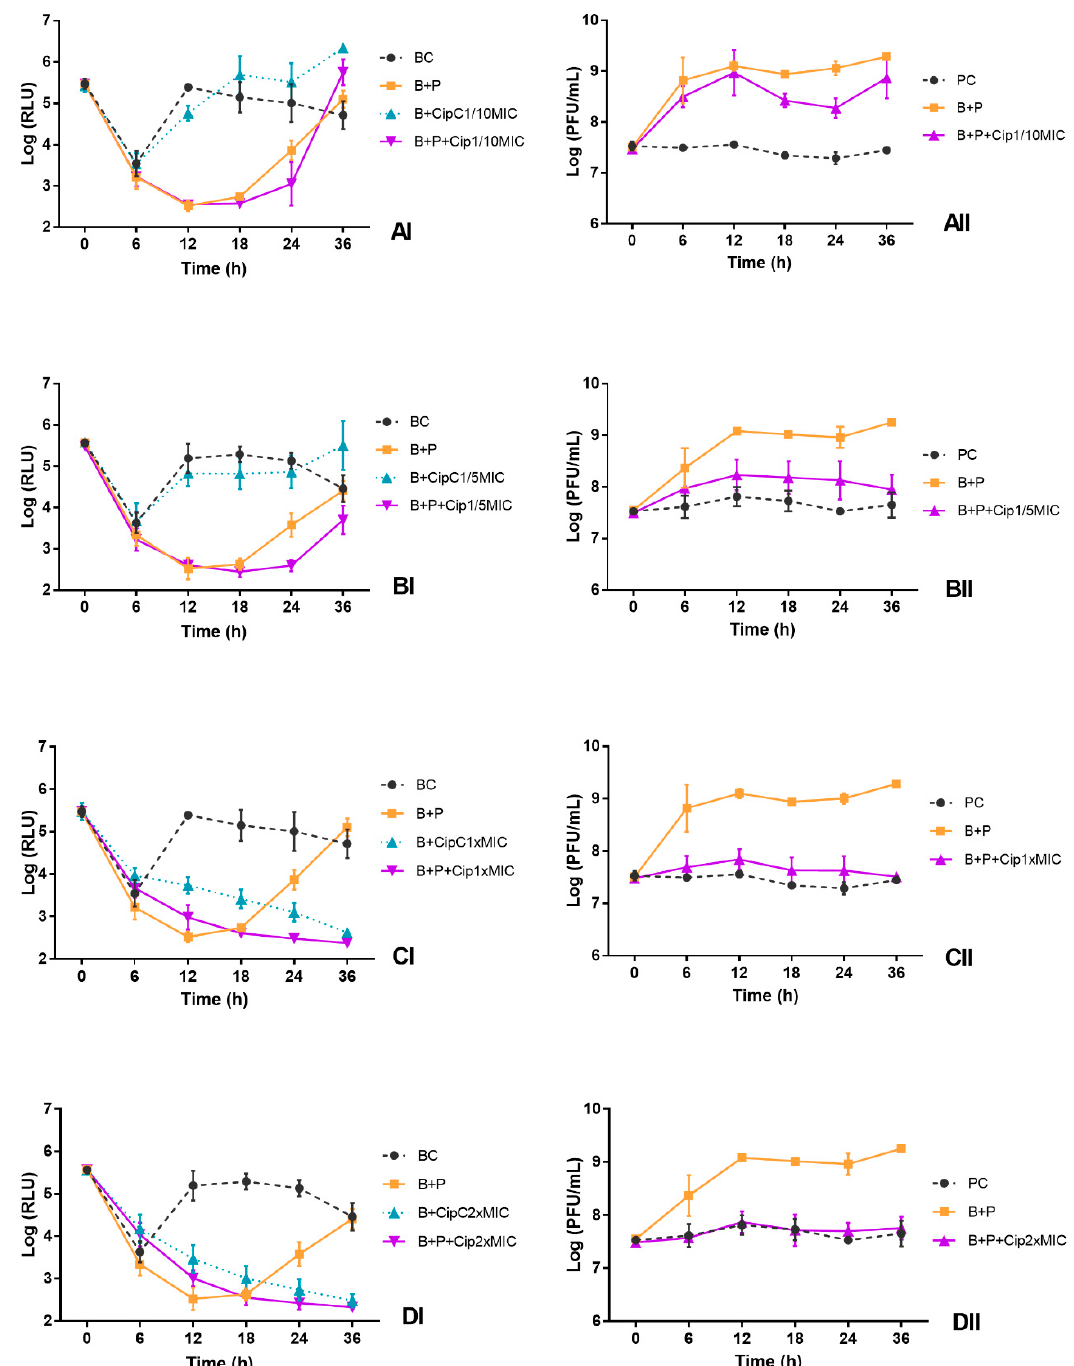
Figure 4. Effect of phage alone (MOI of 100) and of combined phage and ciprofloxacin treatments at different concentrations (( A ) 1/10MIC, ( B ) 1/5MIC, ( C ) MIC and ( D ) 2 × MIC) on the inactivation of bioluminescent E. coli (I) and the phage concentration (II) in TSB during 36 h. BC, bacterial control; PC, Phage control; B + P, bacteria plus phage; B + CipC, bacteria plus ciprofloxacin; B + P + Cip, bacteria plus phage plus antibiotic. Values represent the mean of three independent experiments.